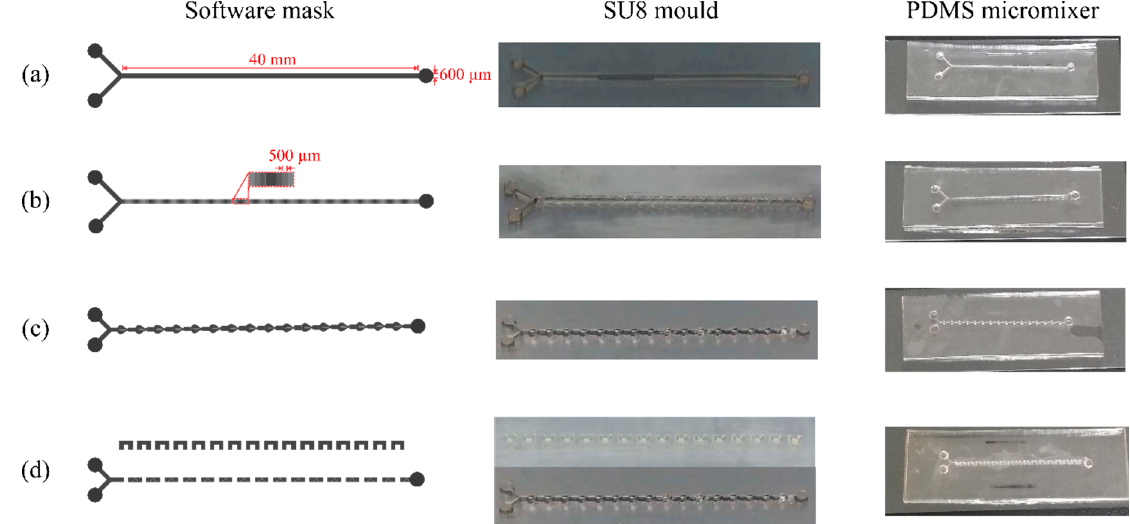
Figure 3. The software mask, SU8 mould and PDMS micromixer for: ( a ) planar, ( b ) multistep, ( c ) B-spline and ( d ) 3D serpentine micromixers.